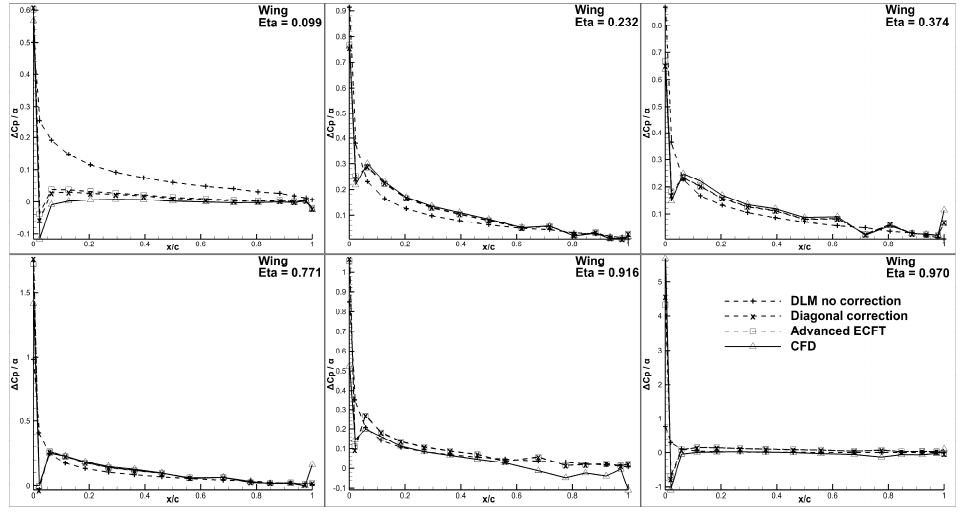
Figure 9. Elastic Δ Cp for a unit α at Wing Component Figure 9. Elastic ∆ Cp for a unit α at Wing